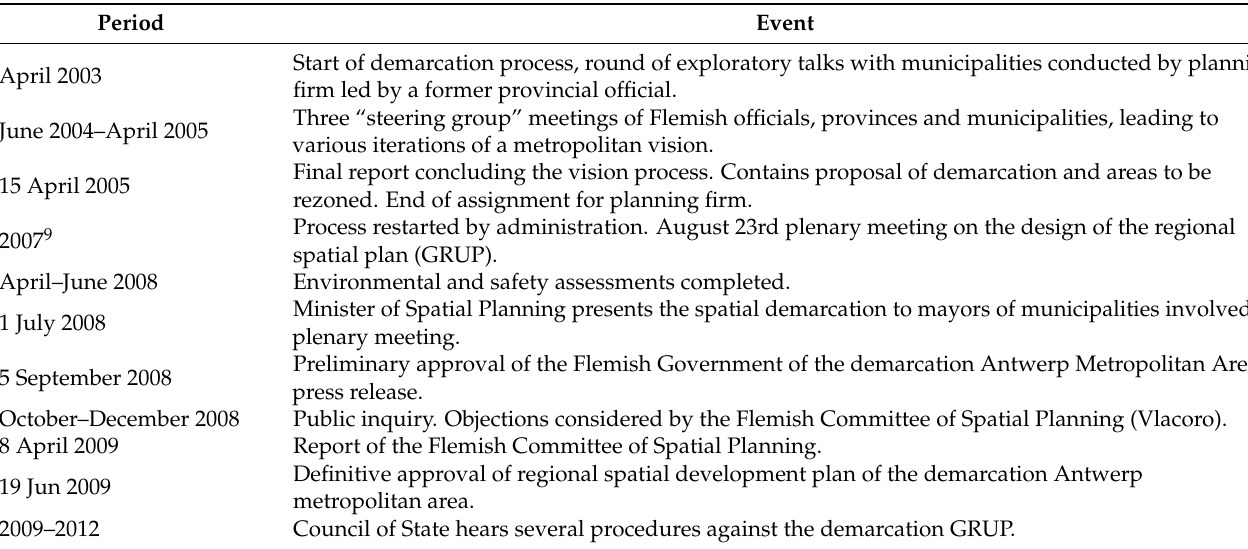
Table 1. Demarcation of the Antwerp Metropolitan Area: